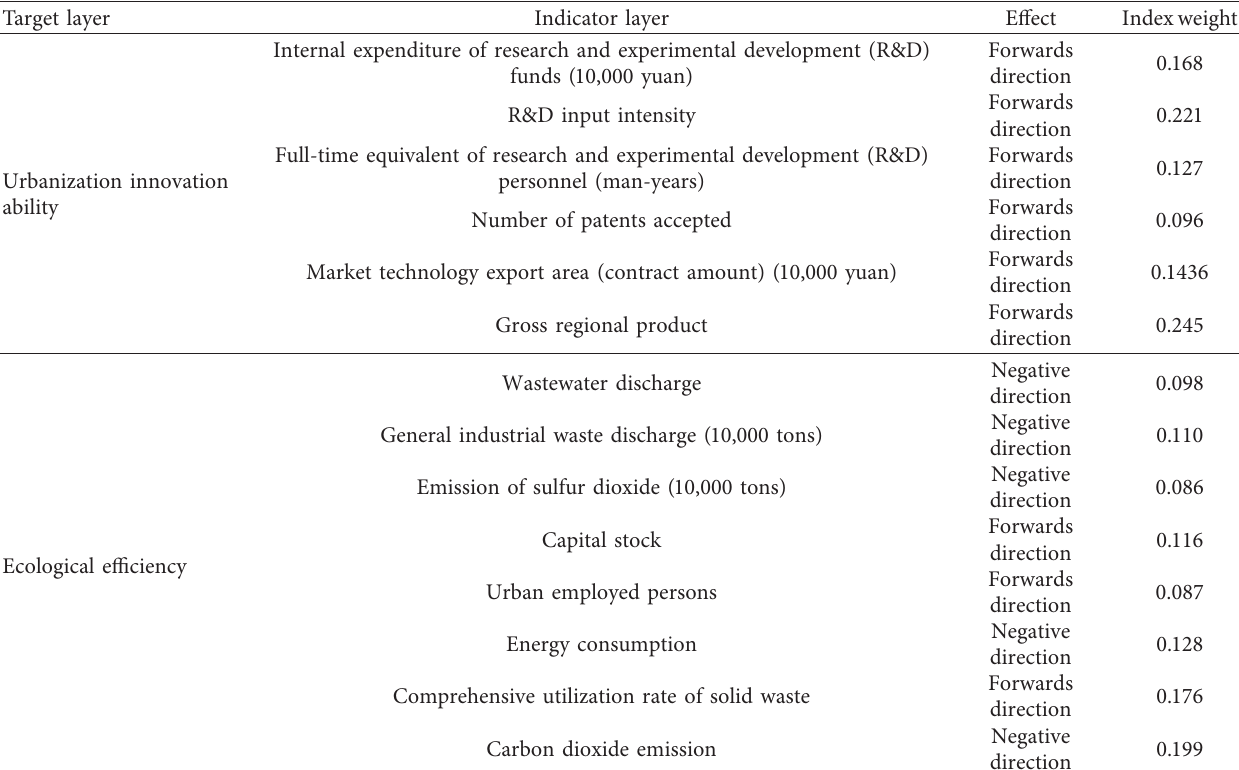
Table 2: Index system of urbanization innovation level and ecological